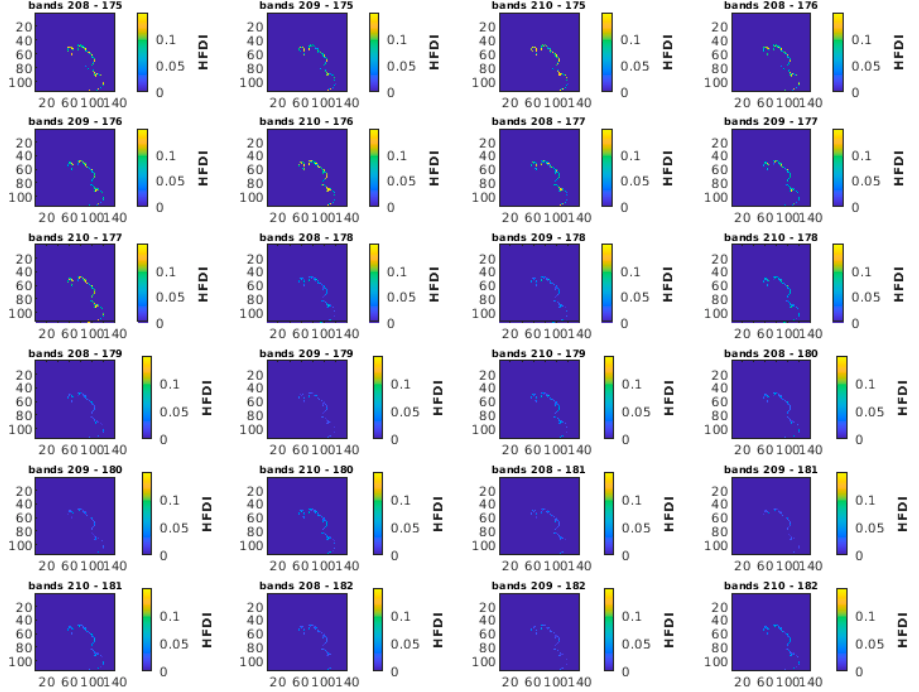
Figure 7. HFDI maps for all twenty-four combinations masked by support vector machine (SVM) classification to evidence fire front.